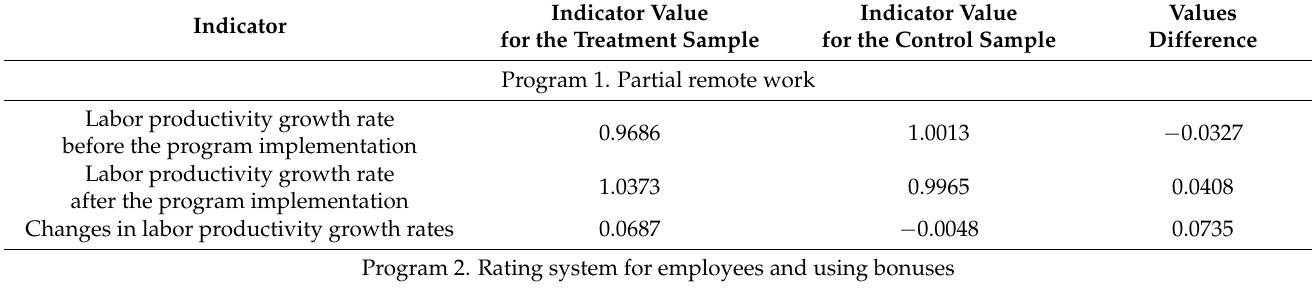
Table 4. Difference-in-difference calculations for programs 1–3 (indicators are measured in %).